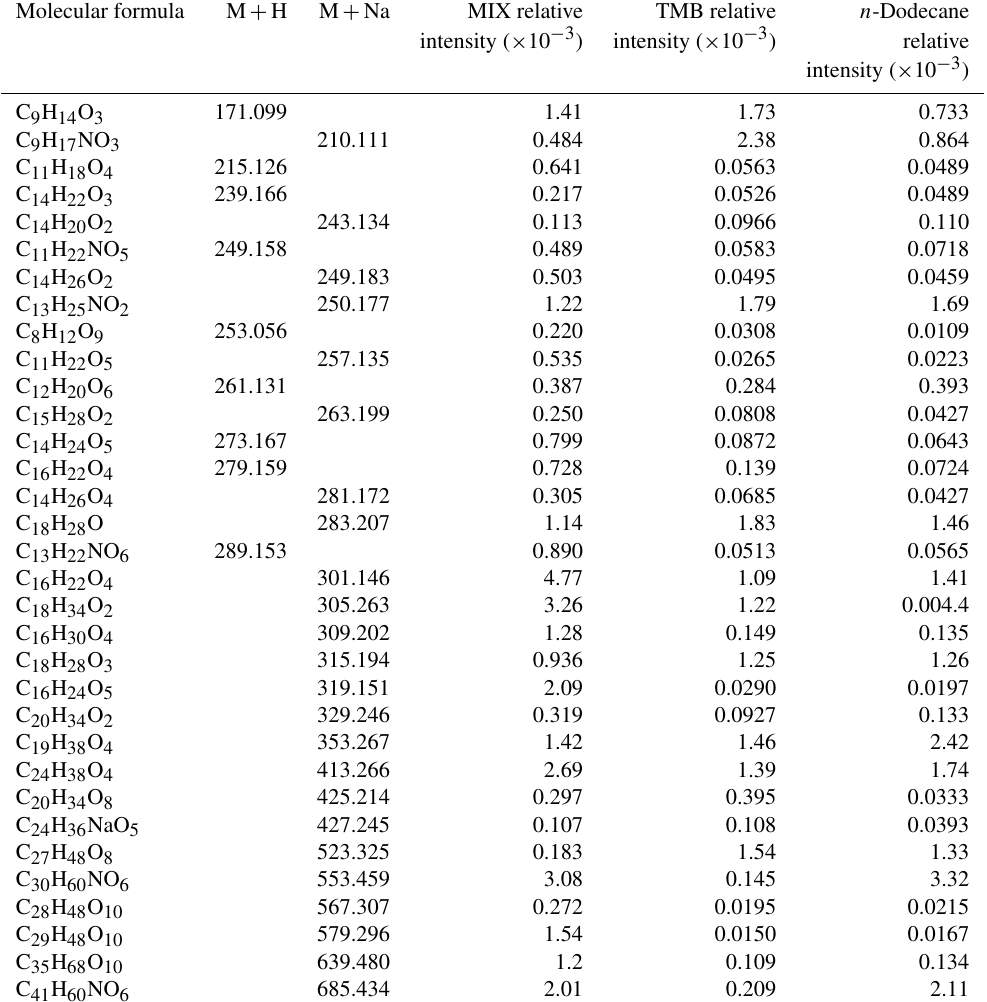
Table 2. Representative identified mass spectral peaks, molecular formulas, molecular weights, and relative intensity of n -dodecane, 1,3,5- TMB, and mixed AVOC-derived